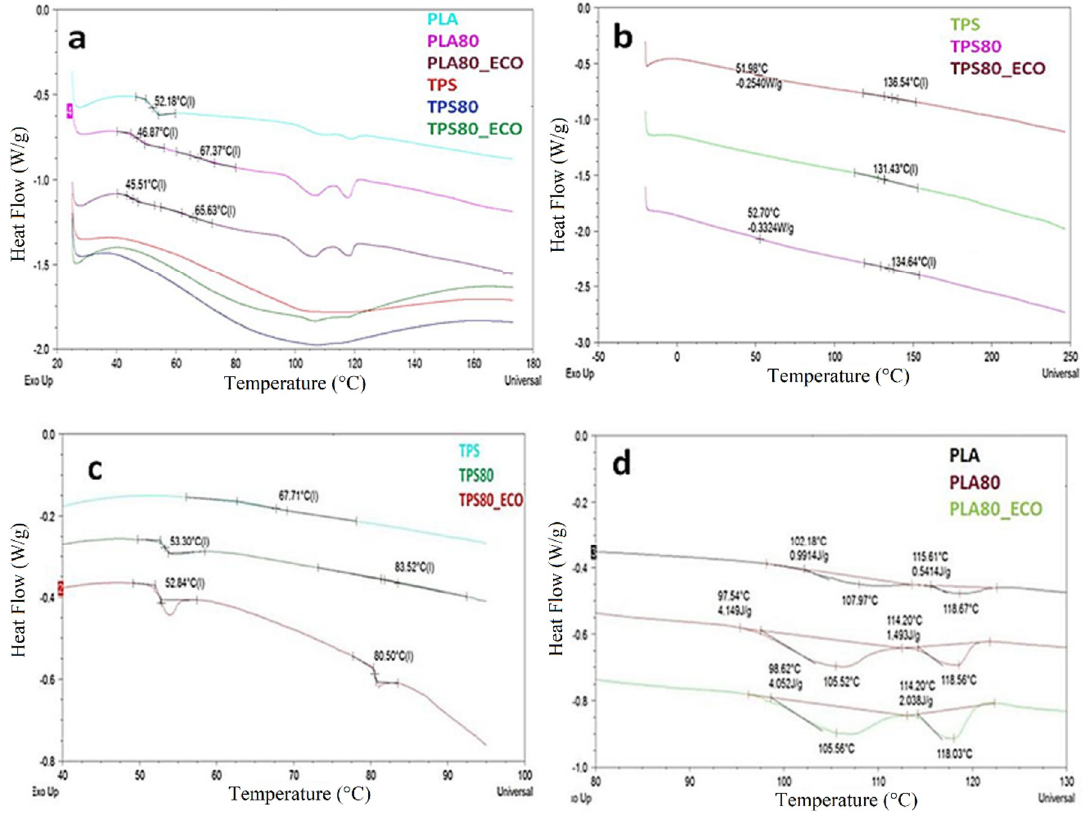
Figure 6. Spectral characterization of the PLA80 film: ( a ) total transmittances (solid lines) and the total reflectances (dash-dotted lines) measured before (black lines) and after (red lines) the treatment. ( b ) Normal transmittance measured before (black line) and after (red line) the treatment. In the inset, images of the PLA80 film before and after the treatment are shown.